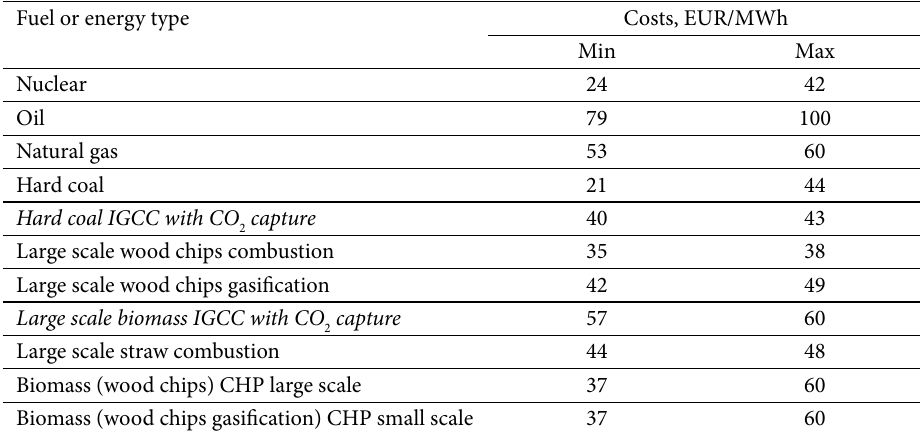
Table 2. Long-term private costs of power generation technologies (2030–2050), EUR/MWh Fuel or energy type Costs,